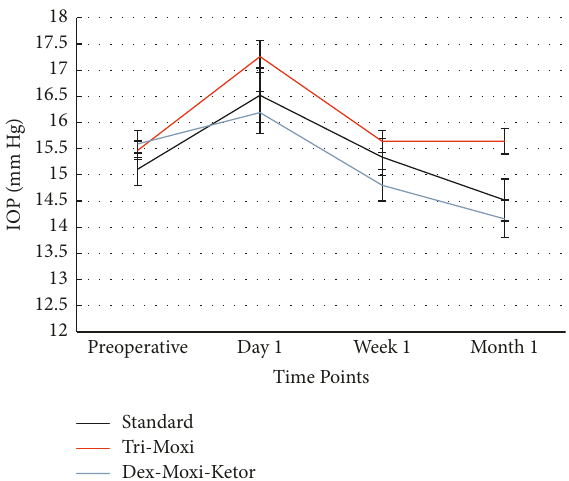
Figure 2: Average intraocular pressure for the treatment groups at preoperative and different postoperative timepoints. Error bars represent standard errors of the means